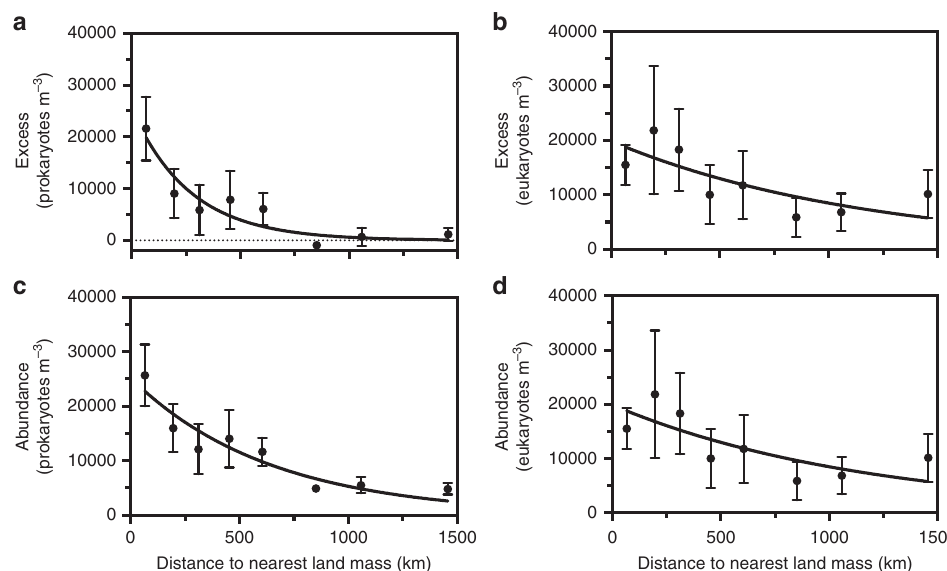
Figure 2 Relationship between the excess and the abundance of microbes with distance to land. The excess of a prokaryotes and b eukaryotes, and the airborne abundances of c prokaryotes and d eukaryotes versus the distance ( D , km) to the nearest land mass. The distance is grouped into 8 bins. Black dots represent the mean values and error bars represent the standard error of the mean (SEM). The solid lines show the fi tted exponential models suggested by the Akaike information criterion ( AIC ) and gives for: a prokaryotic excess (cells m − 3 ) = 25454e ( − 0.0037 D ) ; R 2 = 0.87; b eukaryotic excess (cells m − 3 ) = 19881e ( − 0.00085 D ) ; R 2 = 0.58; c prokaryotic abundance (cells m − 3 ) = 25217e ( − 0.0016 D ) ; R 2 = 0.88; d eukaryotic abundance (cells m − 3 ) = 19883e ( − 0.00085 D ) ; R 2 =